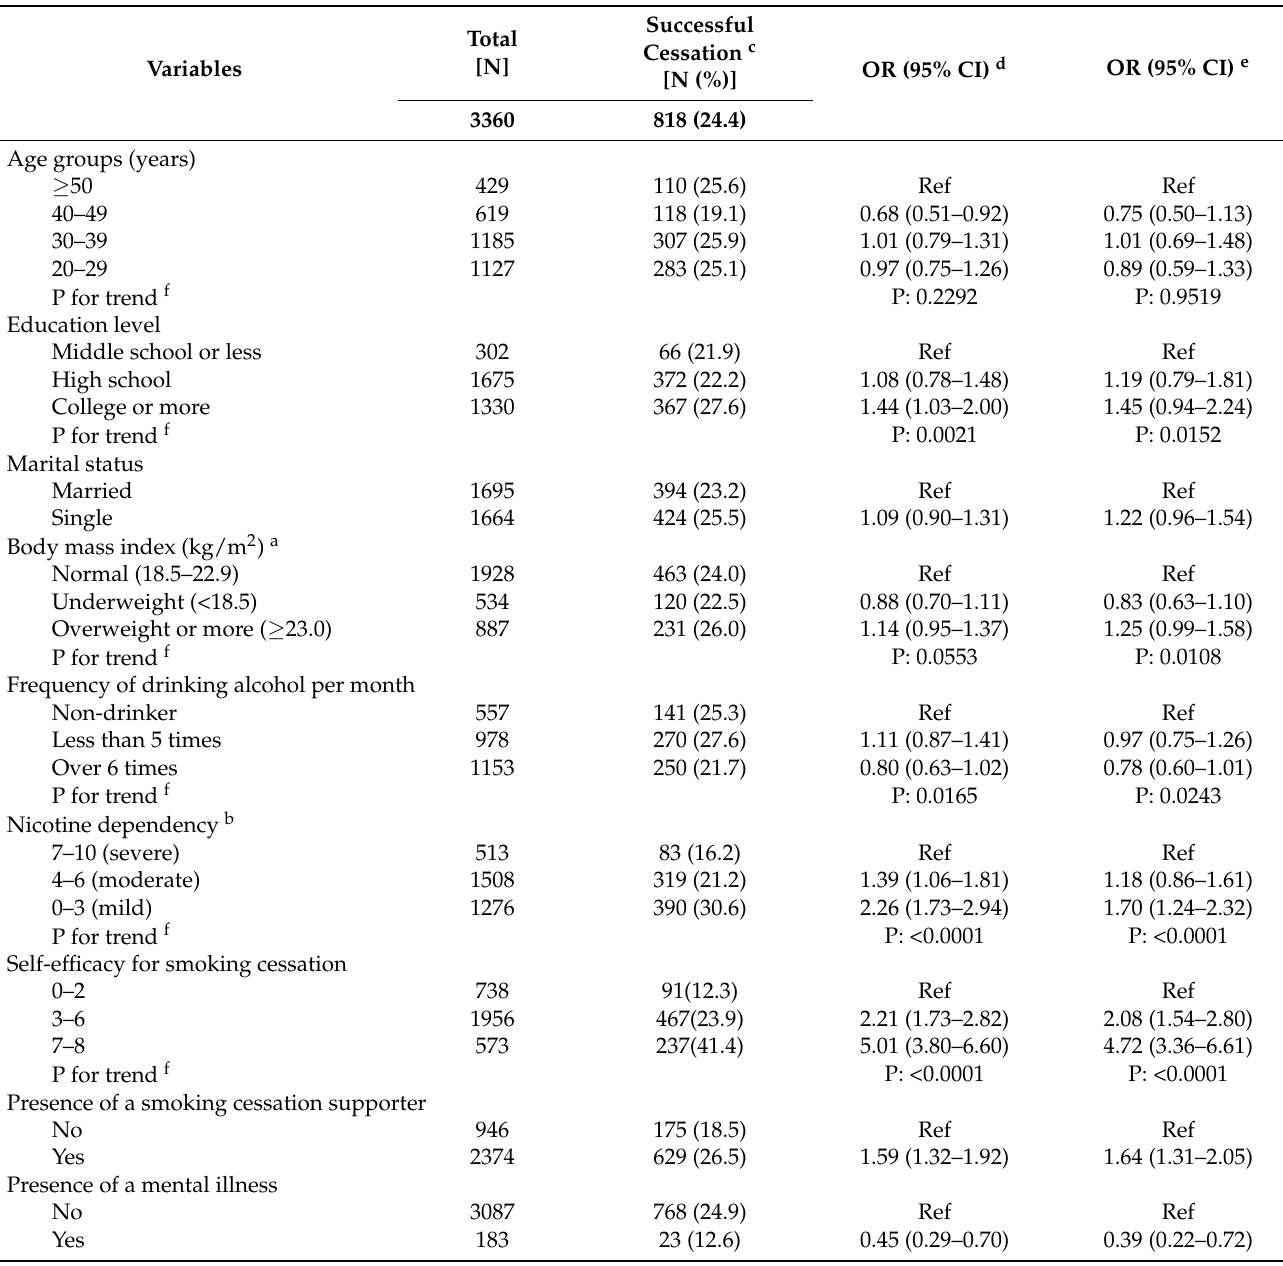
Table 2. Odds ratios and 95% confidence intervals of potential factors associated with smoking cessation at the 30-day